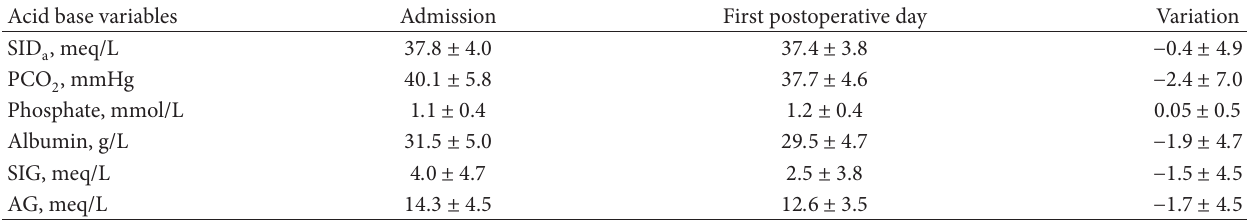
Table 2: Variation of anion gap and its predictors between admission and first postoperative day ( 𝑁 = 128 ).